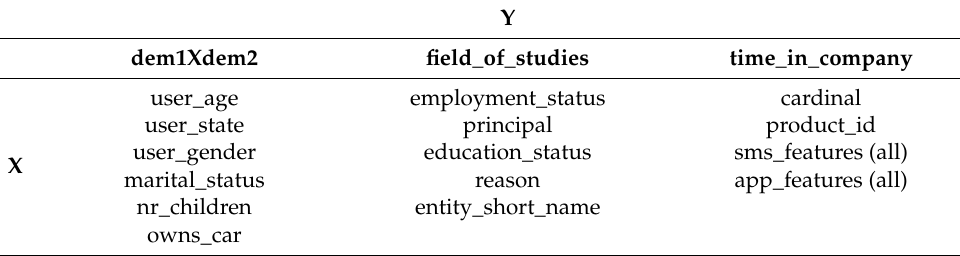
Table 4. Distribution of the variables per different